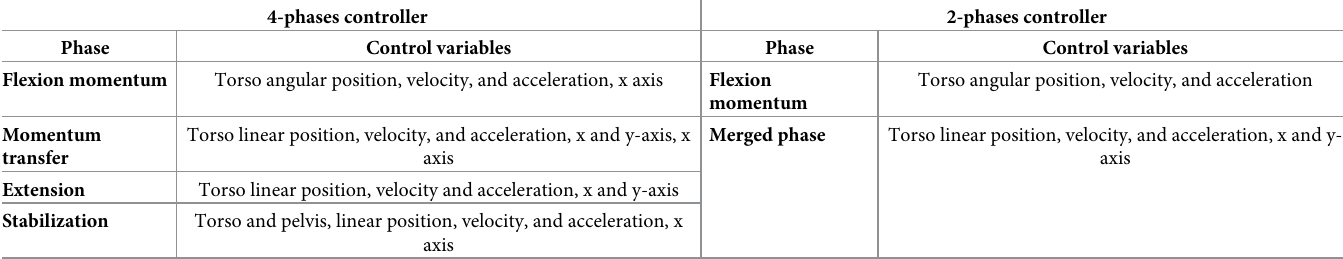
Table 2. Control variables for both